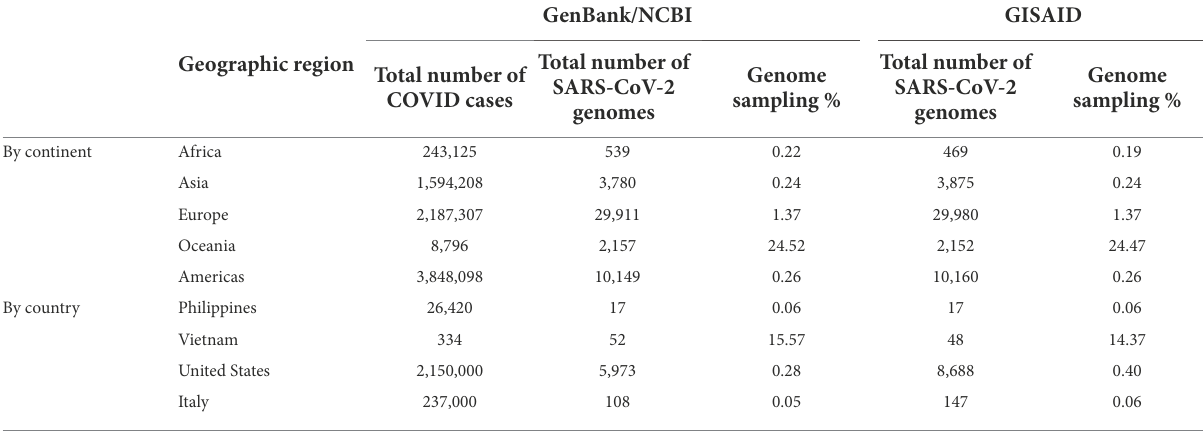
TABLE 4 SARS-CoV-2 reference genomes and cases by geographic region at the time of viral genome sequencing from Theodore Roosevelt outbreak (up to June 12, 2020). GenBank/NCBI Geographic region